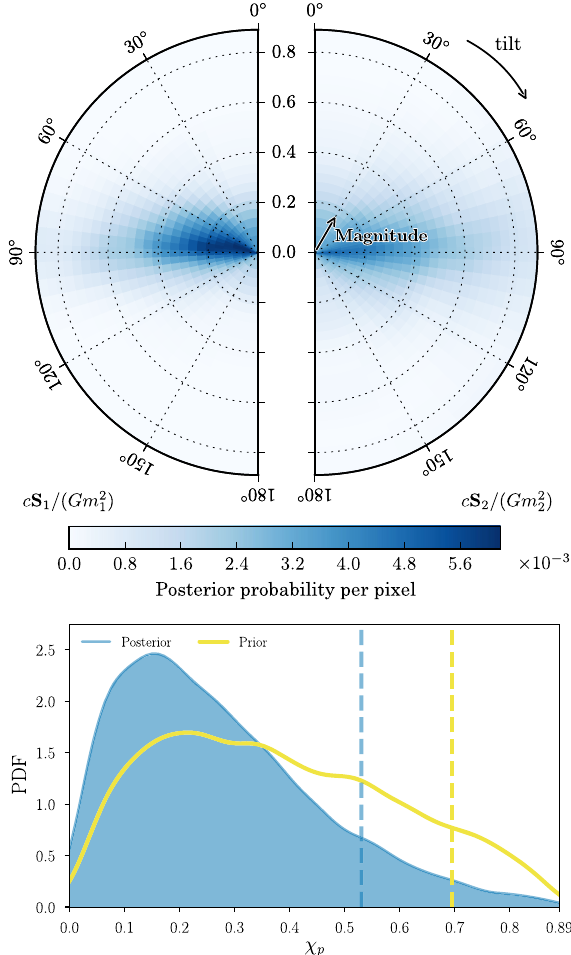
FIG. 8. Top panel: Inferred spin parameters using the Phe- nomPNRT model in the high-spin case, where the dimensionless component spin magnitudes χ < 0 . 89 . Plotted are the probability densities for the dimensionless spin components χ 1 and χ 2 relative to the orbital angular momentum L , plotted at the reference gravitational-wave frequency of f ¼ 100 Hz. A tilt angle of 0° indicates alignment with L . Each pixel has equal prior probability. Bottom panel: The posterior for the precession parameter χ p , plotted together with its prior distribution, also plotted at the reference frequency of f ¼ 100 Hz. The vertical lines represent the 90th percentile for each